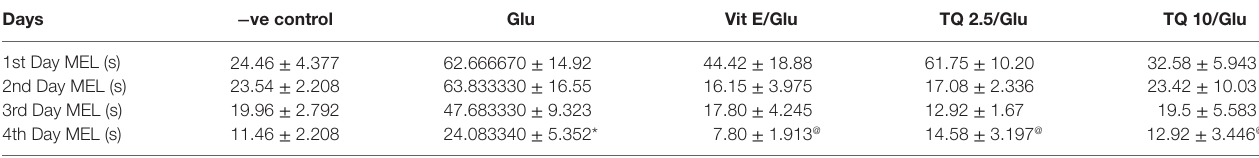
TaBle 2 | Effect of Glu, Vit E/Glu, TQ 2.5/Glu, and TQ 10/Glu on the mean escape latency (MEL) in Morris water maze (MWM) test.